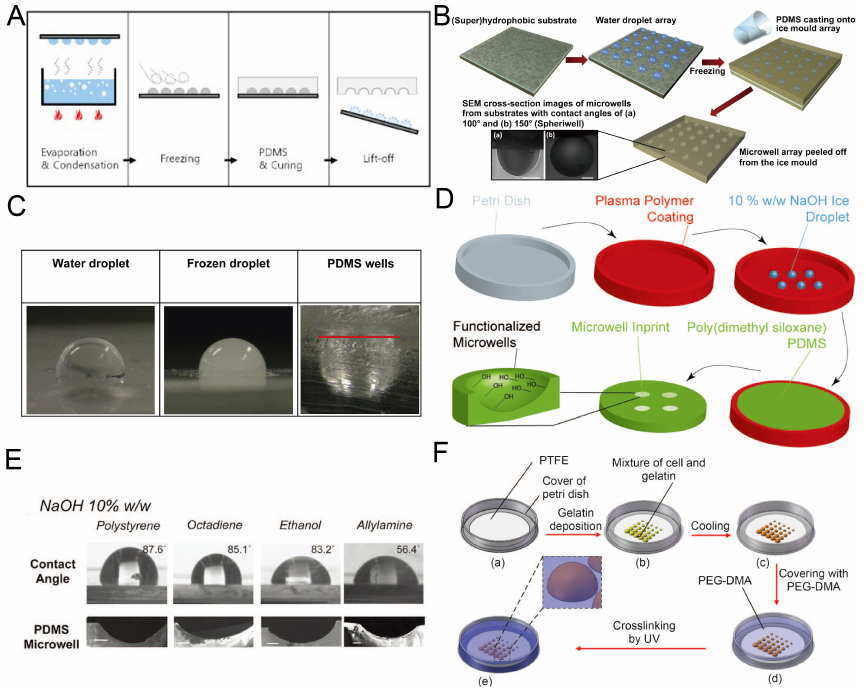
Figure 5. Replica molding of frozen liquid droplets. ( A ) Water vapor was condensed on a rigid sub- strate to form droplets. PDMS was poured on the substrate after the droplets were frozen. PDMS with concave microwells was ready after curing and lift-off [56]. Reprinted (adapted) from [56]. Copyright (2008) with permission from Springer Nature. ( B ) A water droplet array was printed on a superhy- drophobic substrate and frozen, and then used as a mold for PDMS replica molding [57]. ( C ) Pictures of a water droplet, frozen droplet and the corresponding wells using the method illustrated in ( B ) [57]. Reprinted (adapted) from [57]. Copyright (2014) with permission from Elsevier. (D) 10% w / w NaOH solution was deposited on a petri dish substrate with plasma polymer coating, frozen and used as a mold for PDMS replica molding to fabricate concave microwells [58]. ( E ) Concave microwells with different dimensions were formed on different substrates using the method described in (D)